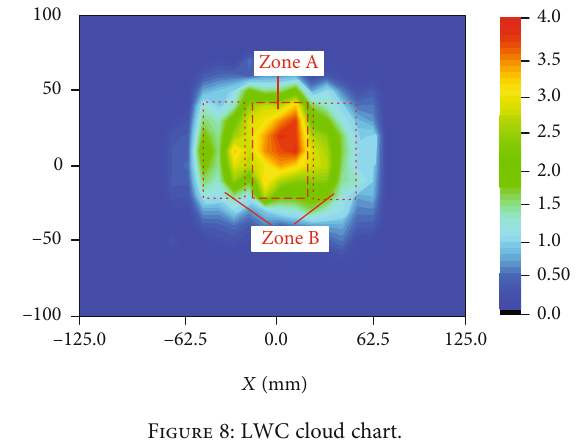
Figure 8: LWC cloud chart.